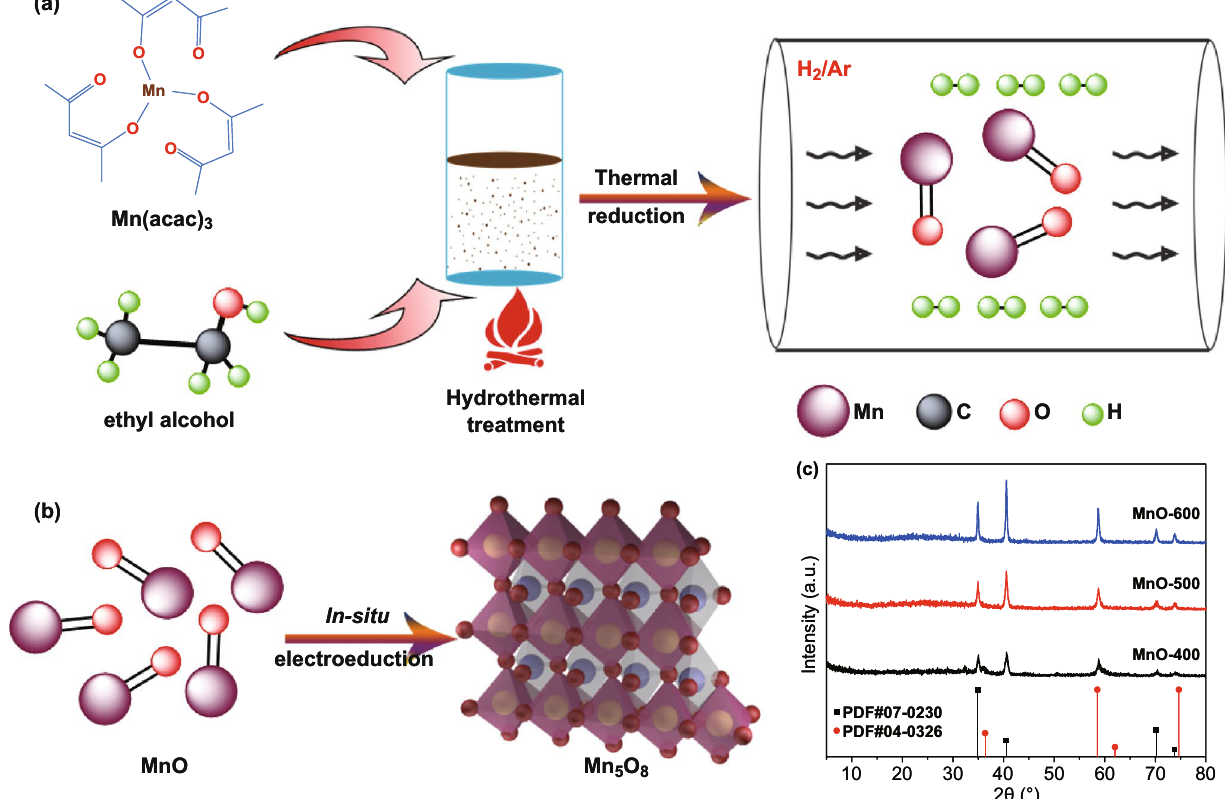
Fig. 1 a Schematic illustration of the synthesis of MnO samples. b Structural evolution schematics of MnO x . c XRD patterns of MnO-T samples ( T = 400, 500, 600